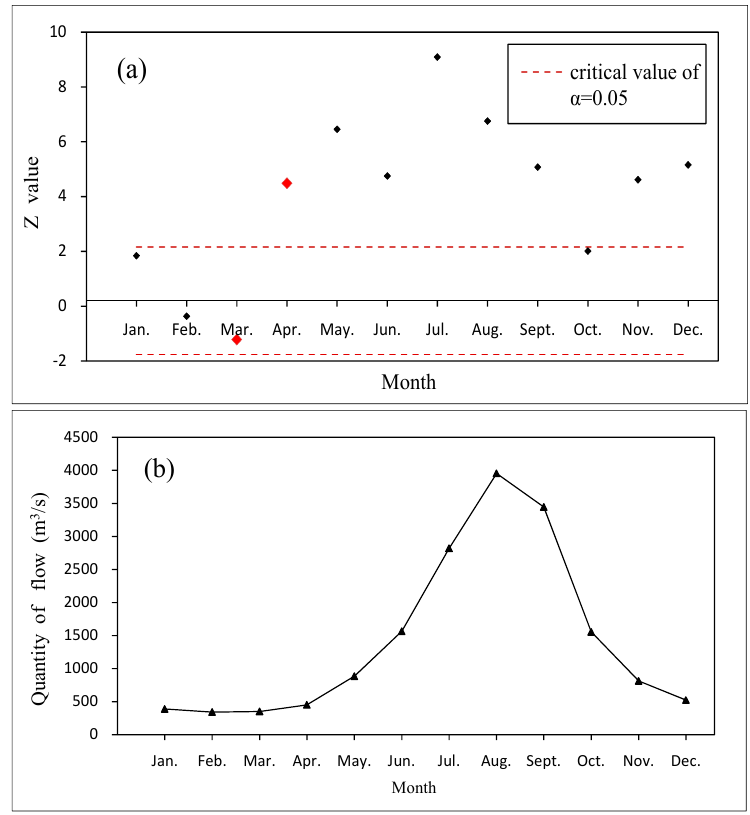
Figure 3. Diagram of the MK test results ( a ) and the curve for monthly average discharge ( b ).